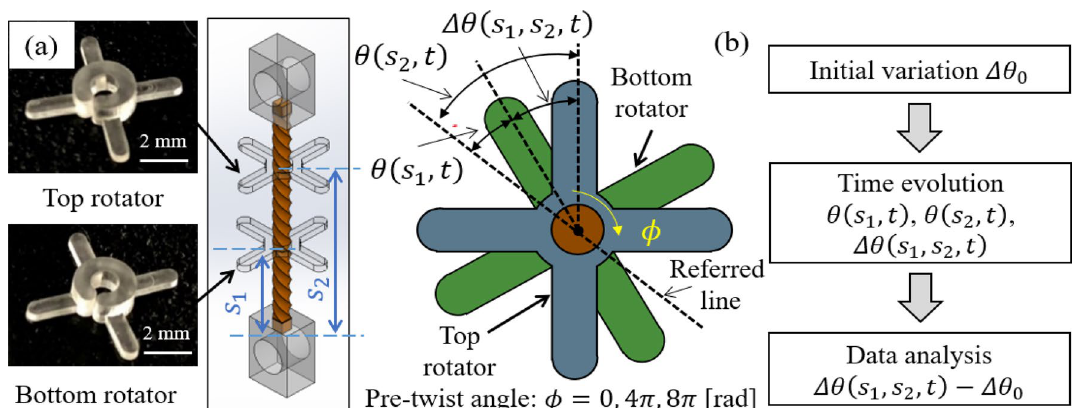
Figure 5. ( a ) Photos of the PDMS rotators and schematic diagram of the calculated angular variation �θ ( s 1 , s 2 , t ) . ( b ) Data analysis procedure. (Middle image of ( a ) is created by Adobe Illustrator (CC2015) https:// www. adobe. com/ jp/ produ cts/ illus trator.